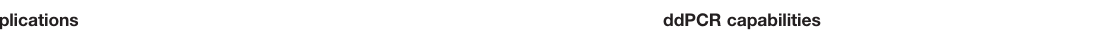
TABLE 11 | Summary of the applications and capabilities of